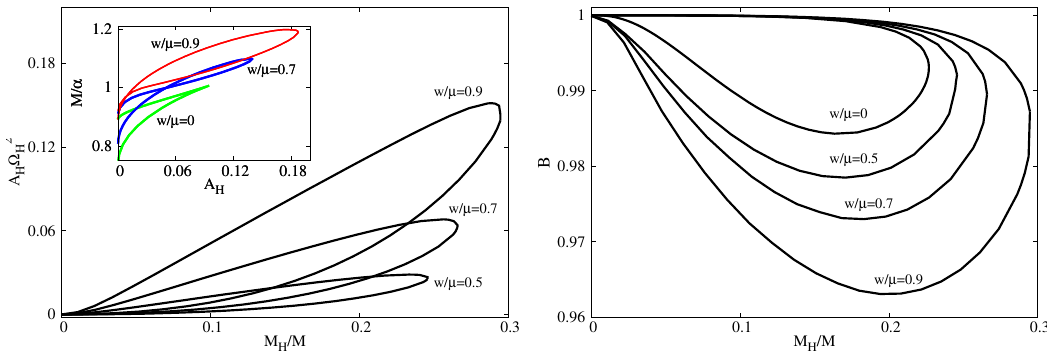
Figure 6 . The dimensionless parameter A H (cid:10) 2 as functions of the hairiness parameter p = M H =M for BH solutions with the coupling constant (cid:11) = 0 :